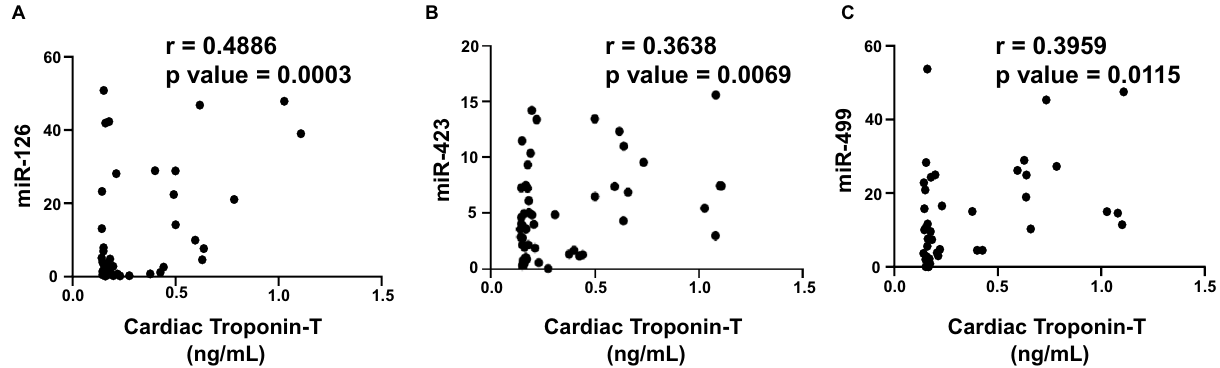
Figure 6. Correlation analysis of circulating miRNAs with high sensitive cardiac troponin T. Correlation was determined using Pearson’s r coefficient using two-tailed p -value to demonstrate significance (alpha = 0.05). Scatter dot plot between cardiac troponin T and circulating miRNAs showing statistical significance, which includes ( A ) mIR-126, ( B ) miR-423 and ( C ) miR-499. Each plot independently shows corresponding correlation coefficient ( r value) and significance ( p